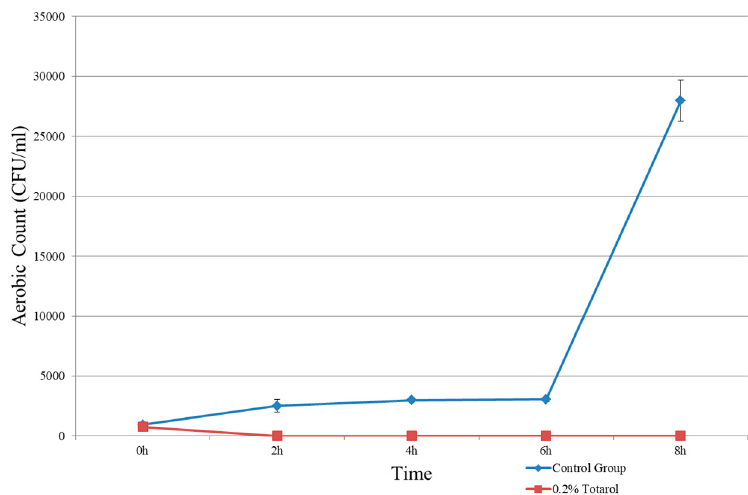
Figure 3. Time needed for antimicrobial effect of totarol.